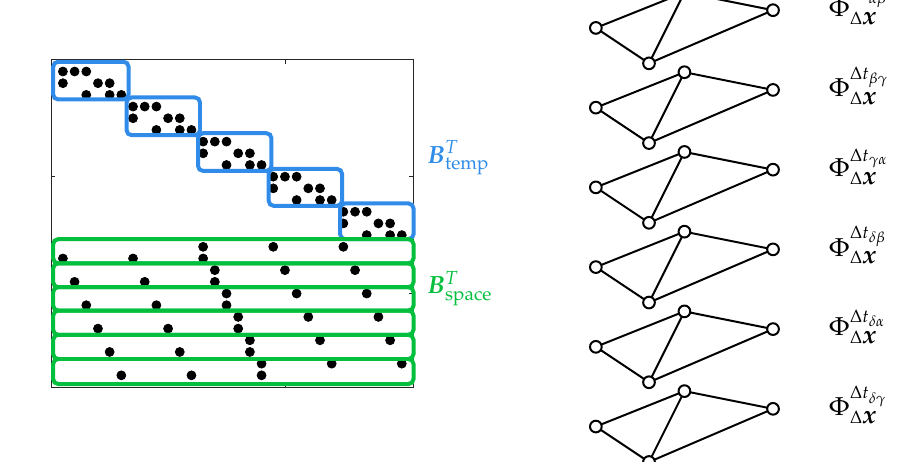
Figure 3. Exemplary structure of global constraint matrix for a small D-InSAR stack consisting of six interferograms between which a total of three temporal constraints can be generated and five spatial gradients, between which two spatial constraints must be